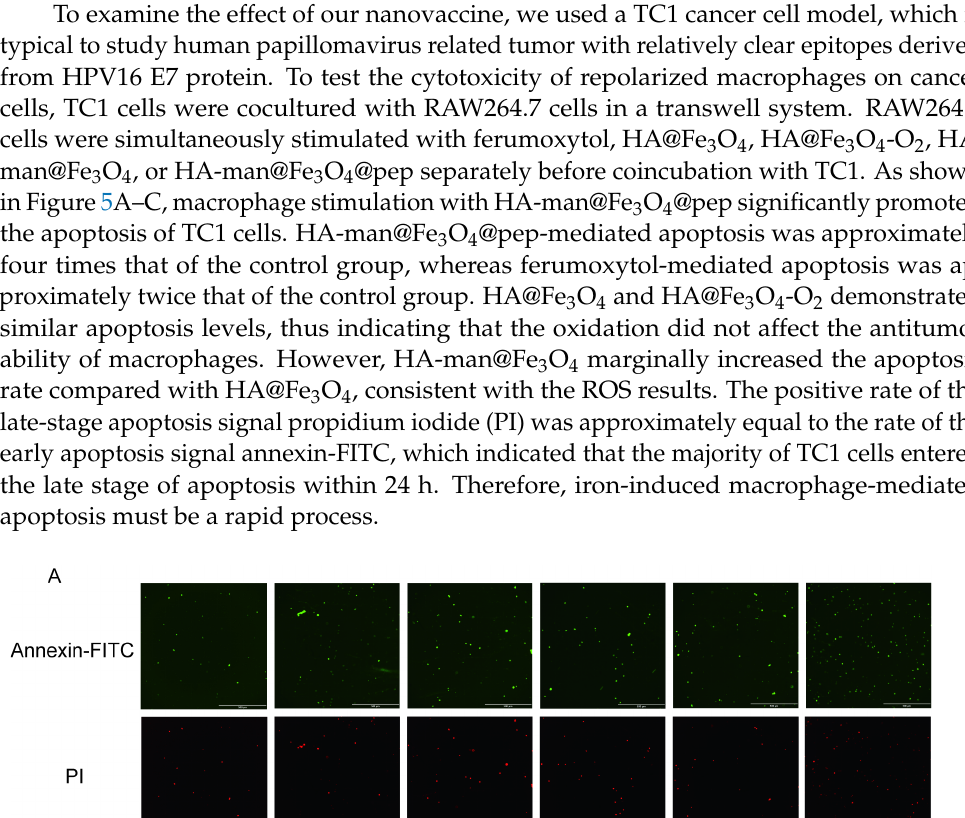
Figure 5. TC1 cell apoptosis in vitro mediated by RAW 264.7 and materials. ( A ) Fluorescence images of TC1 cells following coculturing with RAW 264.7 cells; ( B , C ) flow cytometry analysis of TC1 cells following coculturing with RAW 264.7 cells. Representative results are displayed. 3.7. Tumor Inhibition In Vivo Immunosuppressive TME is one of the major hurdles for enhanced cancer vaccine therapy and TAMs are abundant and of significance to help tumor cells escape from im- mune supervision. Therefore, we hypothesized that HA-man@Fe 3 O 4 might be used as ad- juvant to first improve the immune condition “soil” in TME and then HA- man@Fe 3 O 4 @pep nanovaccine could promote efficacy further (Scheme 1). To test this strat- egy, we investigated the antitumor effect in a TC1 tumor-bearing mouse model in vivo and waited for tumor volume reaches 100 mm 3 to start the therapy in order to mimic the real cases in cancer patients and ensure enough macrophage recruitment and infiltration.